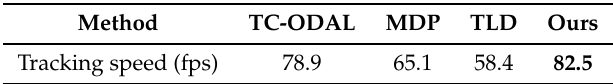
Table 4. The tracking speed (higher is better) of different methods. The best value is highlighted using a bold typeface.